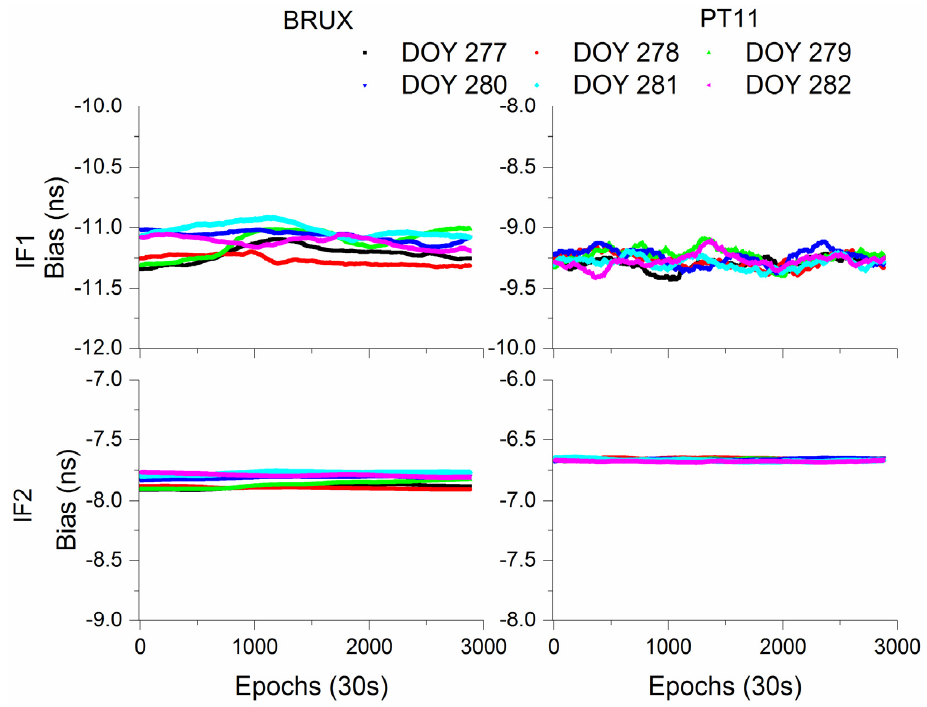
Figure 22. Analysis of two IFB parameters time series for Galileo UC model at BRUX and PT11 stations.